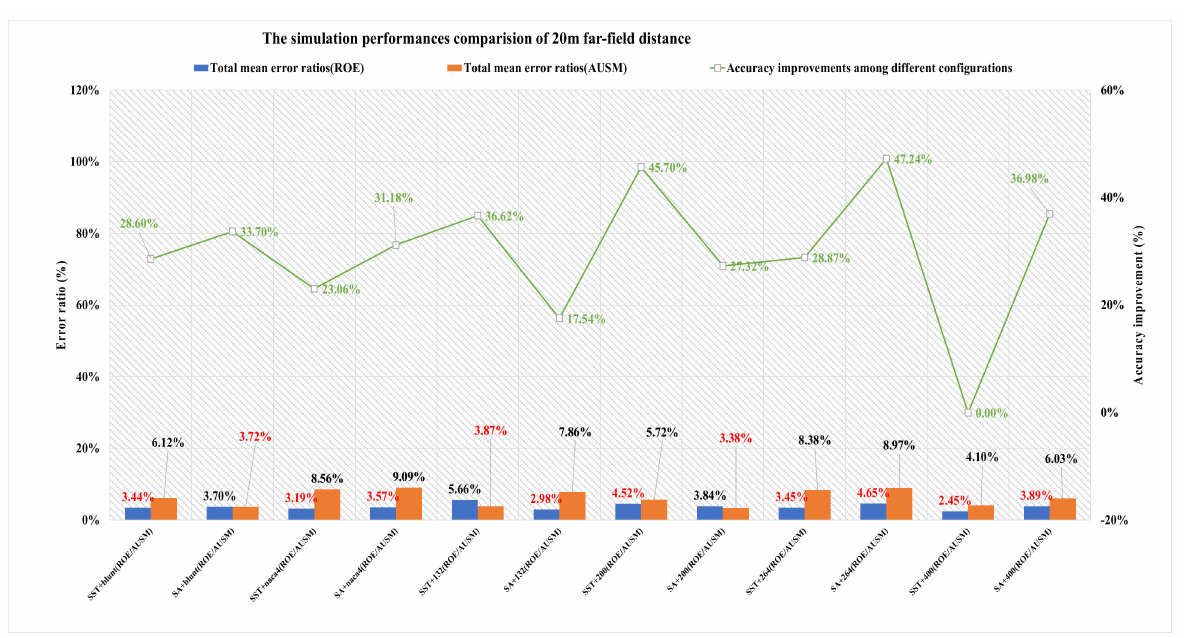
Figure 28. Comparison of the simulation performances of 20 m far-field distance under different simulation